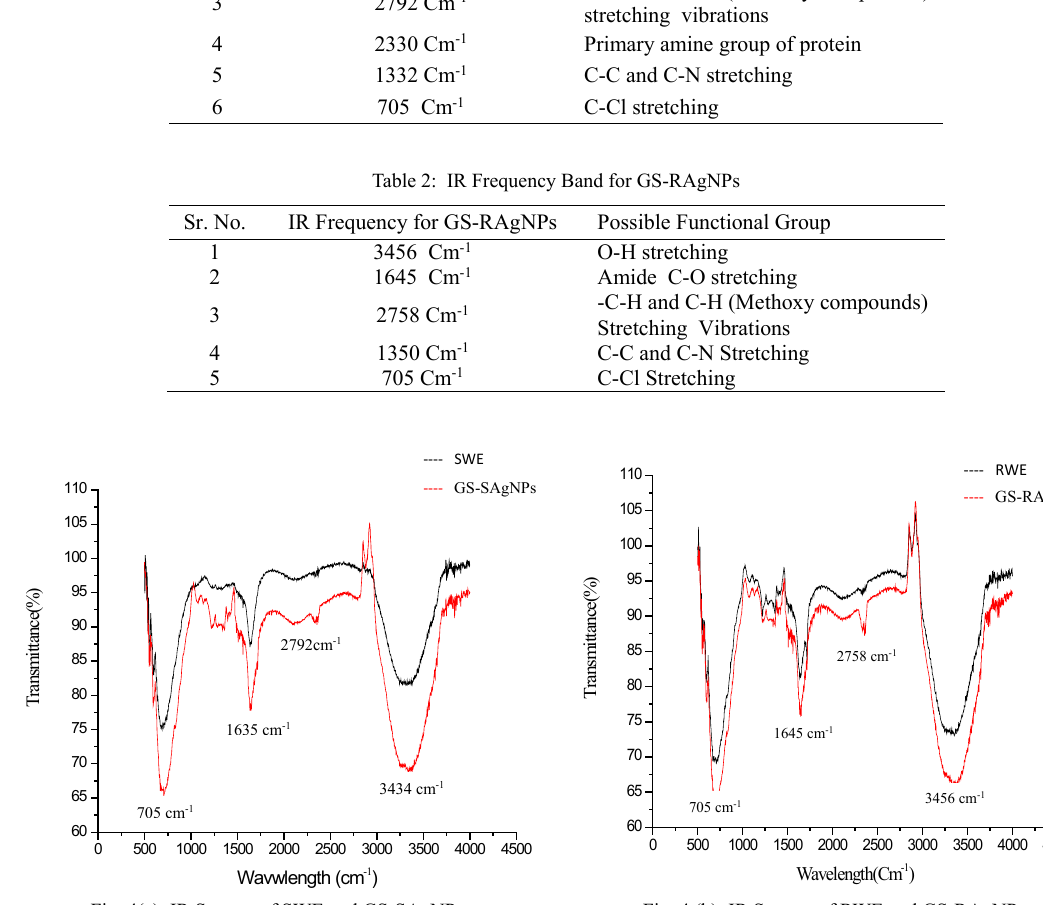
Fig. 4(a): IR Spectra of SWE and GS-SAgNPs Fig. 4 (b): IR Spectra of RWE and GS-RAgNPs